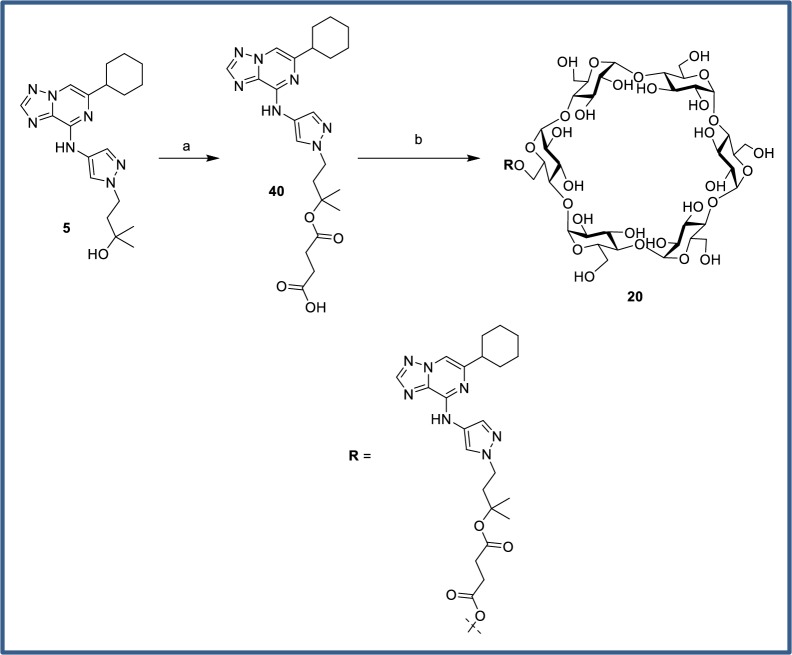
Chemical synthesis of tertiary alcohol-linked cyclodextrin prodrug.Reagents and conditions: (a) Et3N, succinic anhydride, DMAP, N-hydroxysuccinimide, toluene, 120°C, 54%; (b) α-cyclodextrin, EDCI, DMAP, rt, 22%.